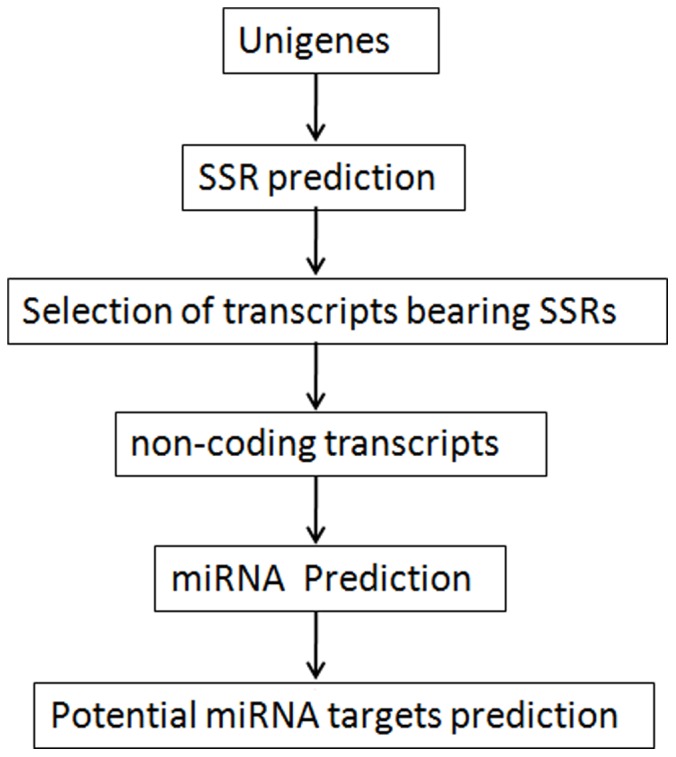
Bioinformatic pipeline followed for identification of SSR bearing pre-miRNAs and its possible targets.